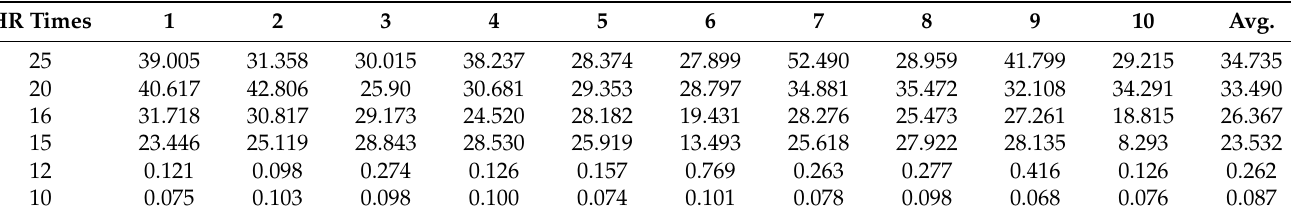
Table 2. Evolution time of circuit-II in different evolvable